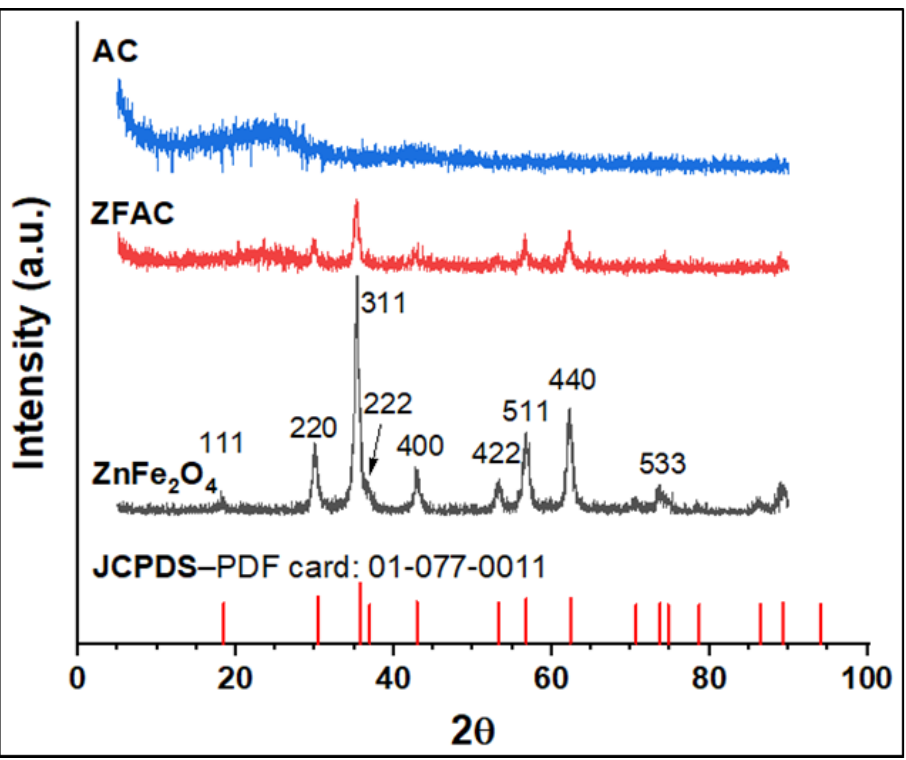
Figure 3. XRD diffractograms of ZnFe 2 O 4 (JCPDS card), ZnFe 2 O 4 (experimental), ZFAC, and AC.